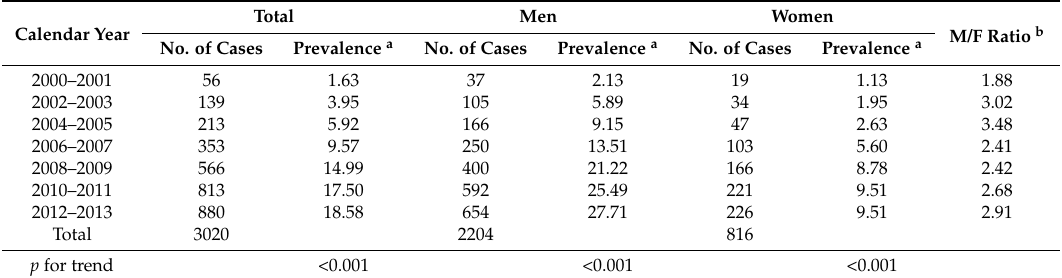
Table 1. Overall and sex-specific biennial numbers and rates of liver transplantation in Taiwan,